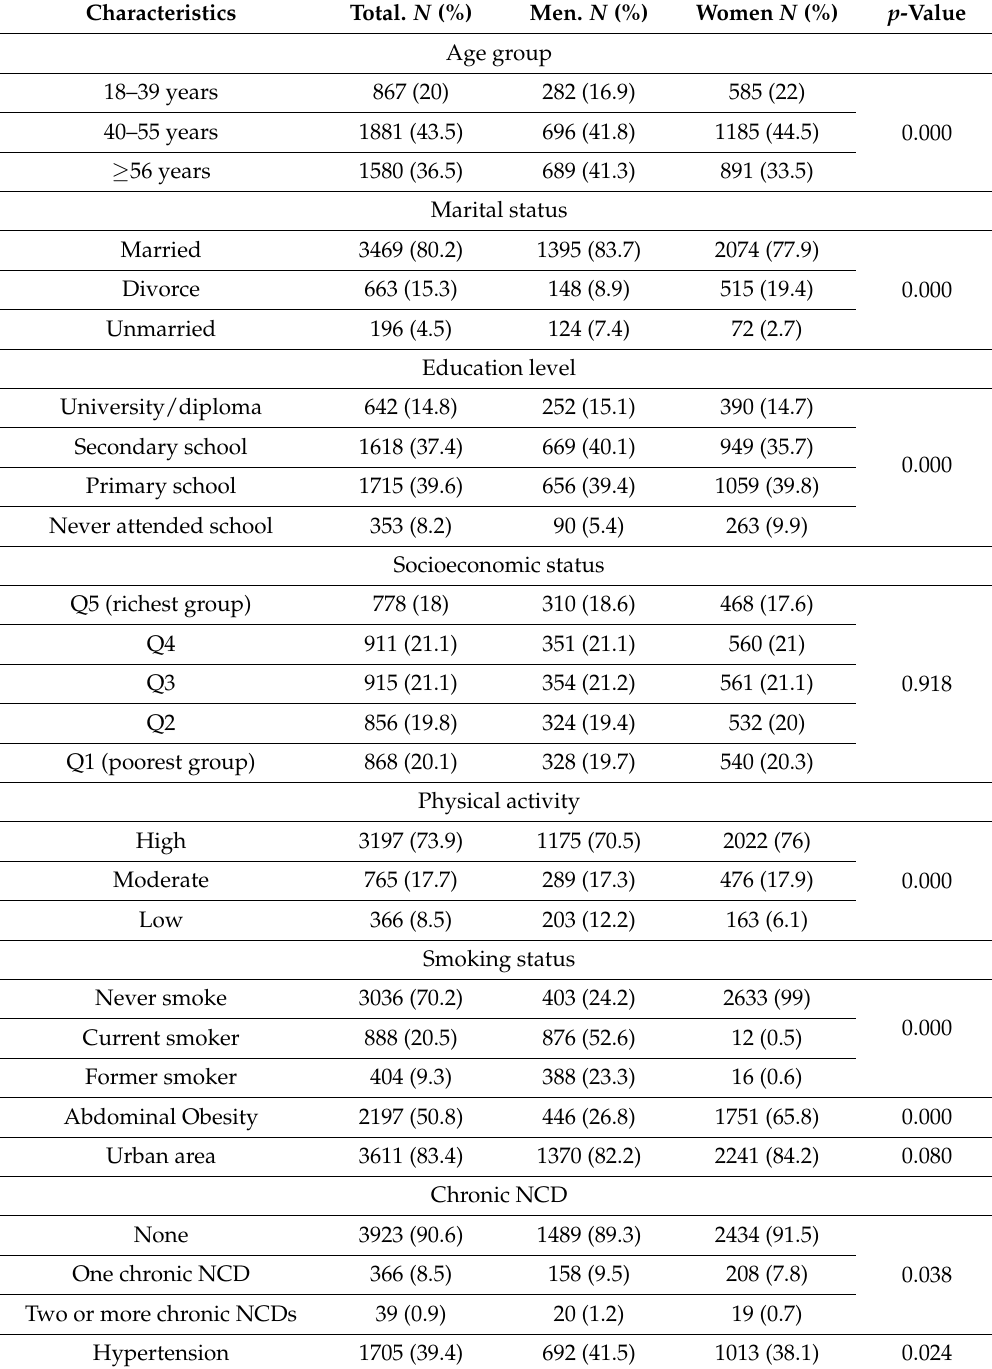
Table 1. Characteristics of HDSS respondents in 2018, in total and by